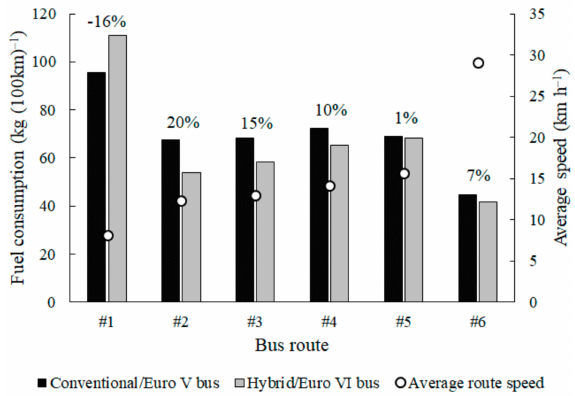
Figure 3. Fuel consumption and percentage difference between the two vehicle types per route, together with mean route